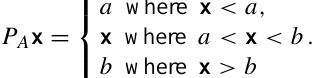
Fig. 5. Comparison of GUVI reconstruction (left) and redline airglow imager (right) for Day 274, 2005.